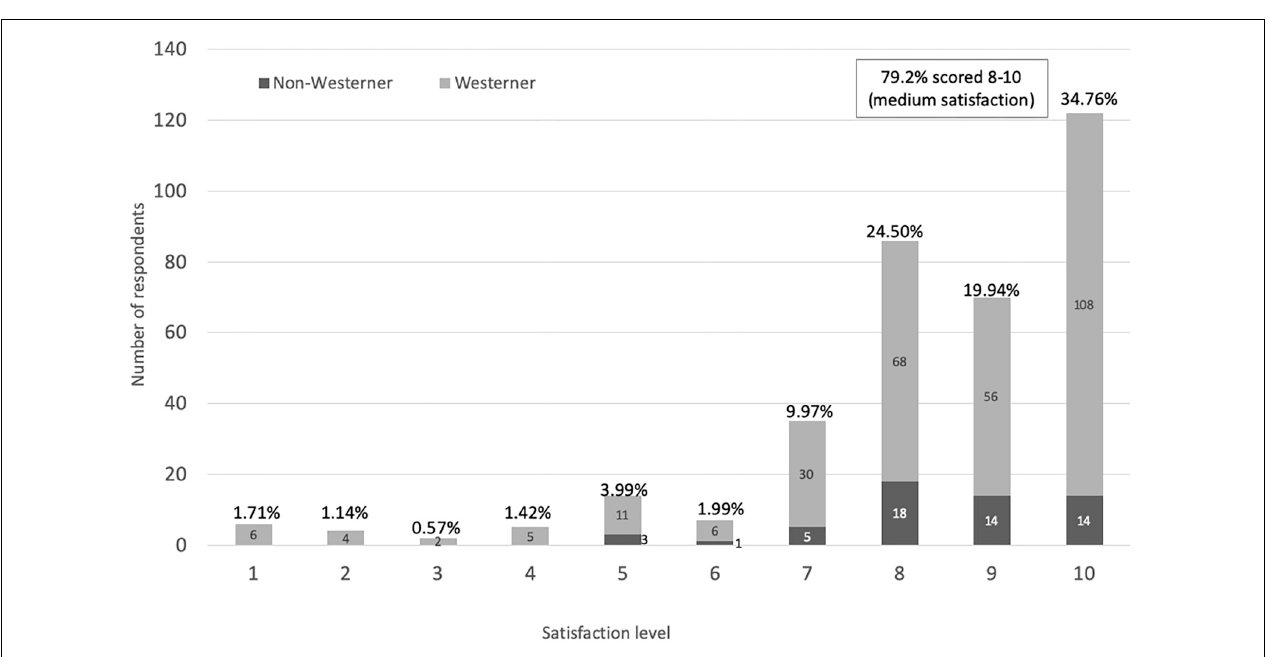
medium association). Nusa Penida, Komodo, and